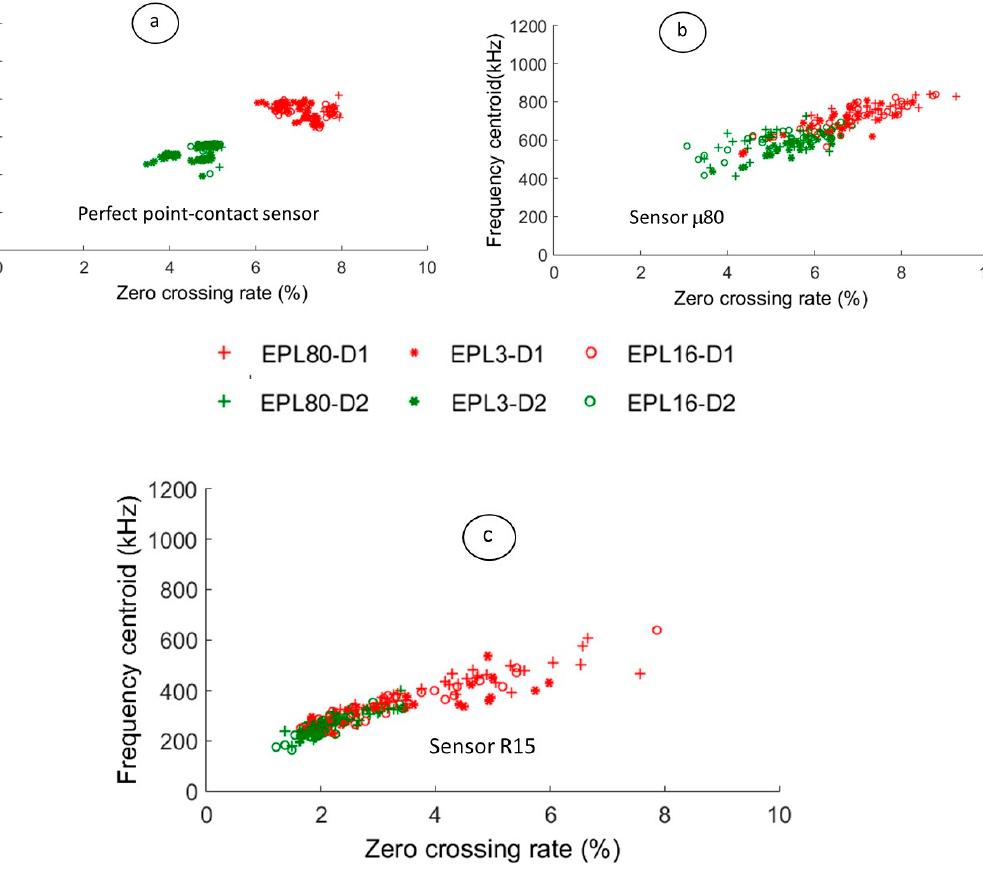
Figure 15. Correlation diagram between frequency centroid and zero crossing rate without sensor effect with a perfect point-contact sensor ( a ), and considering the effect of a μ 80 sensor ( b ) and R15 sensor ( c ).